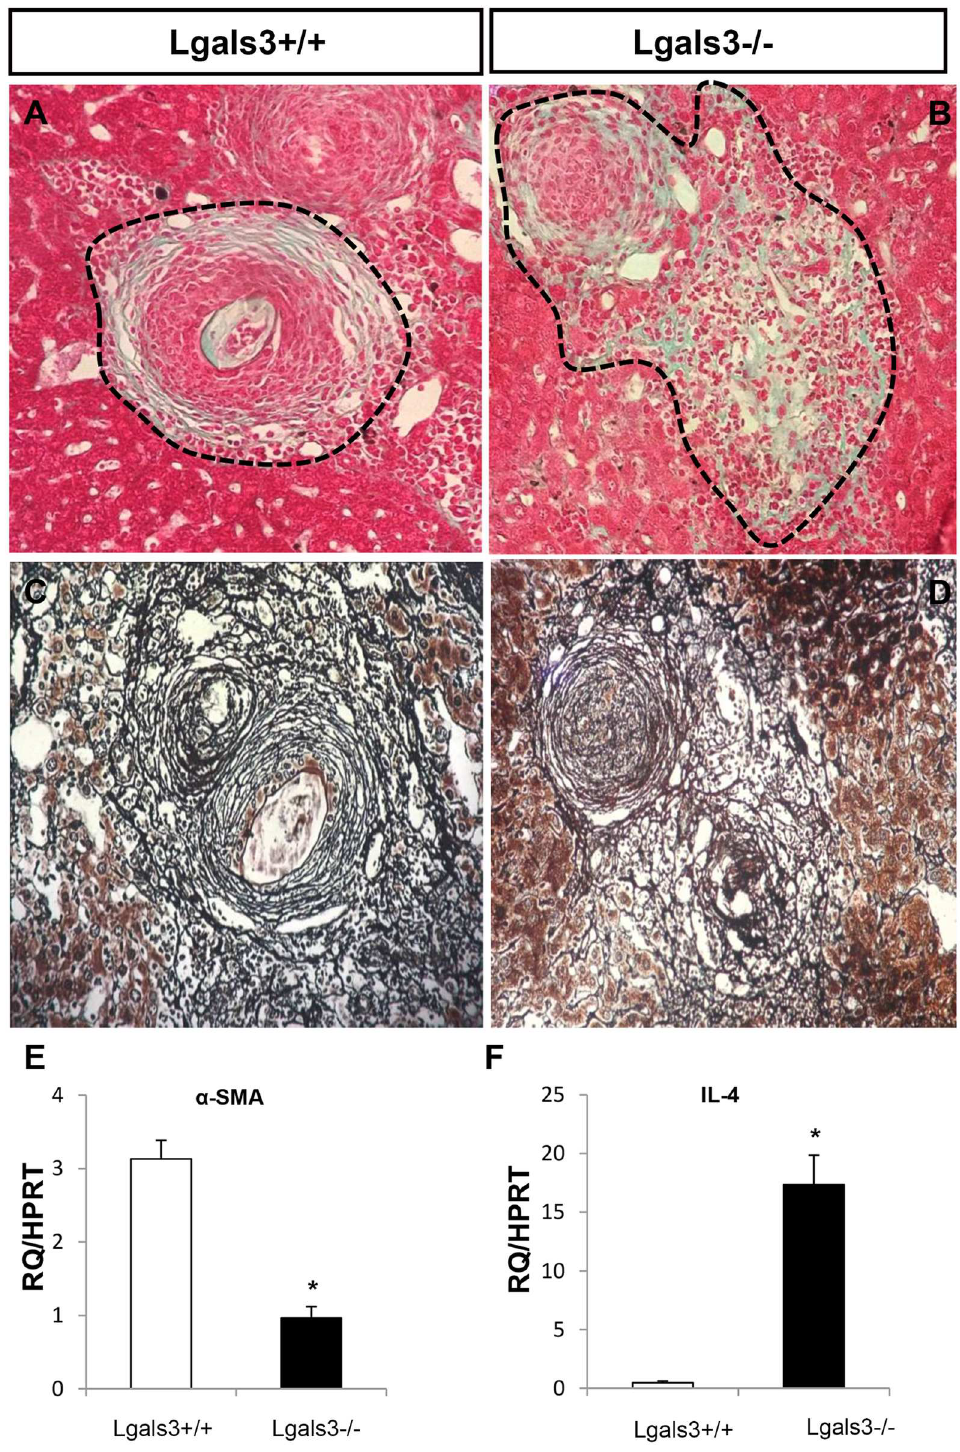
Fig 2. Gal-3 is necessary for fibrotic concentric granulomas in S . mansoni infected mice and myofibroblast activation. Hematoxylin & eosin and Gomori trichrome staining show classical concentric fibrotic granulomasof Lgals3+/+ (A,C dashedline) and more diffuse and dispersedcollagenfibers aroundthe S . mansoni eggs of Lgals3-/- mice (B,D dashedline). Real-timereverse transcription PCR (RT-PCR) to alpha smooth muscle actin (E) and IL-4 (F) expressedby granuloma-hepatic stellate cells (GR-HSCs) from Lgals3+/+